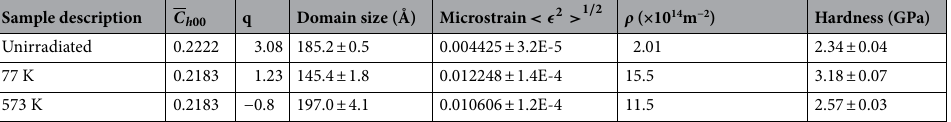
Table 2. Microstructural parameters extracted from XRD data for the samples irradiated to a dose of 0.2 dpa.